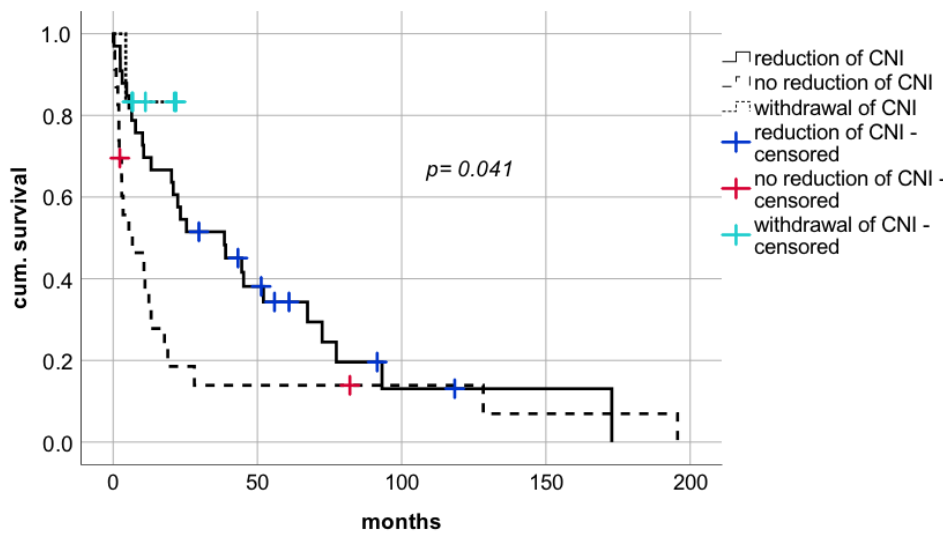
Figure 5. Impact on modification of immunosuppressive therapy after diagnosis of de novo lung carcinoma after liver transplantation. CNI — calcineurin inhibitors .